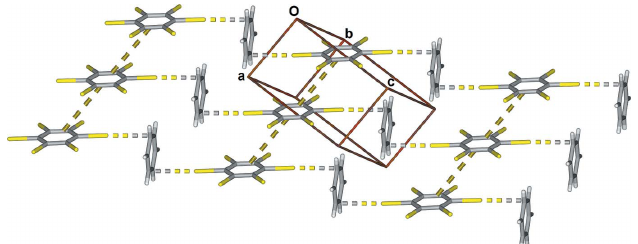
Figure 3 Partial view of the crystal structure of the title solvate showing the stepped chain formed by the C—I (cid:2)(cid:2)(cid:2) (cid:2) interactions and also showing the offset (cid:2) -stacking of the 1,4-diiodotetrachlorobenzene molecules.